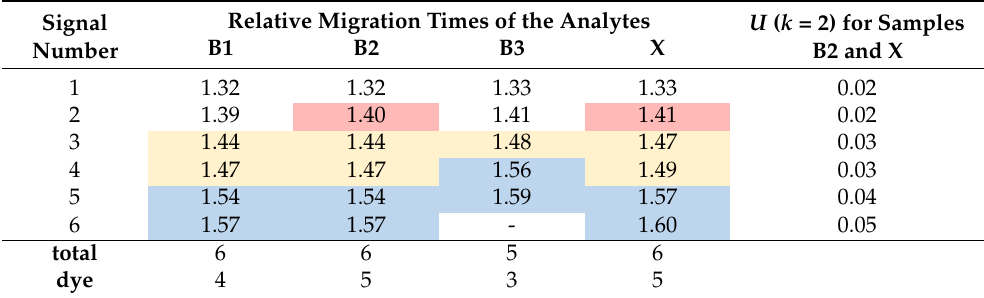
Table 4. Results of differentiation of samples B1–B3 and X; yellow, red, and blue colors corresponding to signals with the maximum absorption bands at 380–490, 490–580, and >580 nm, respectively. Signal